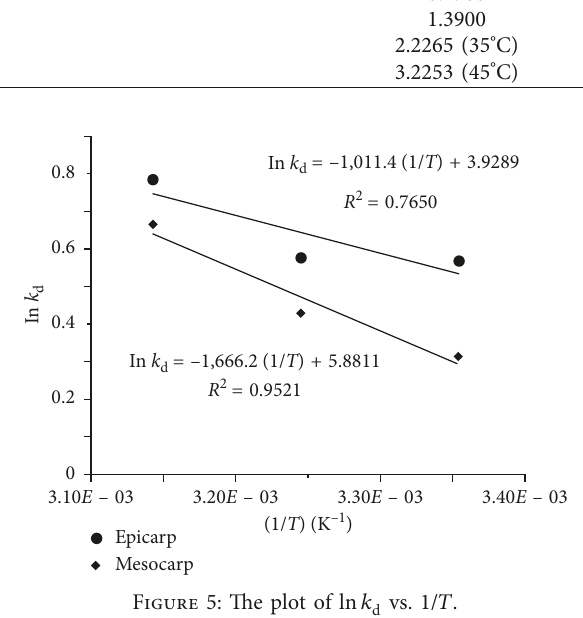
Figure 5: The plot of ln k vs. 1/ T . d